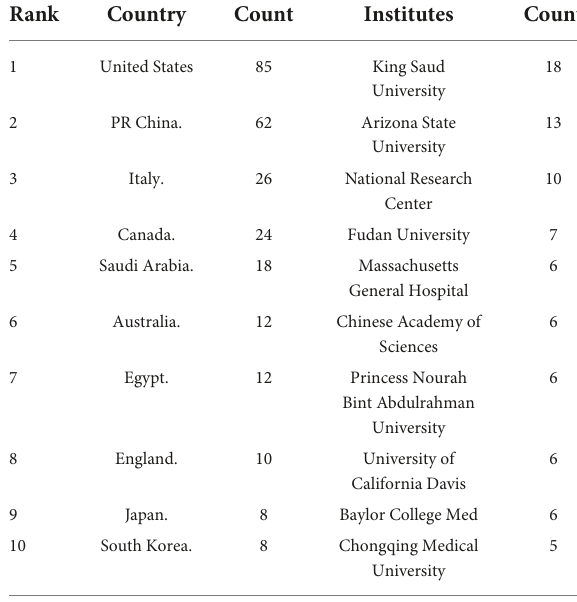
TABLE 1 The top 10 countries and institutions on publications in ASD and microbiota research.